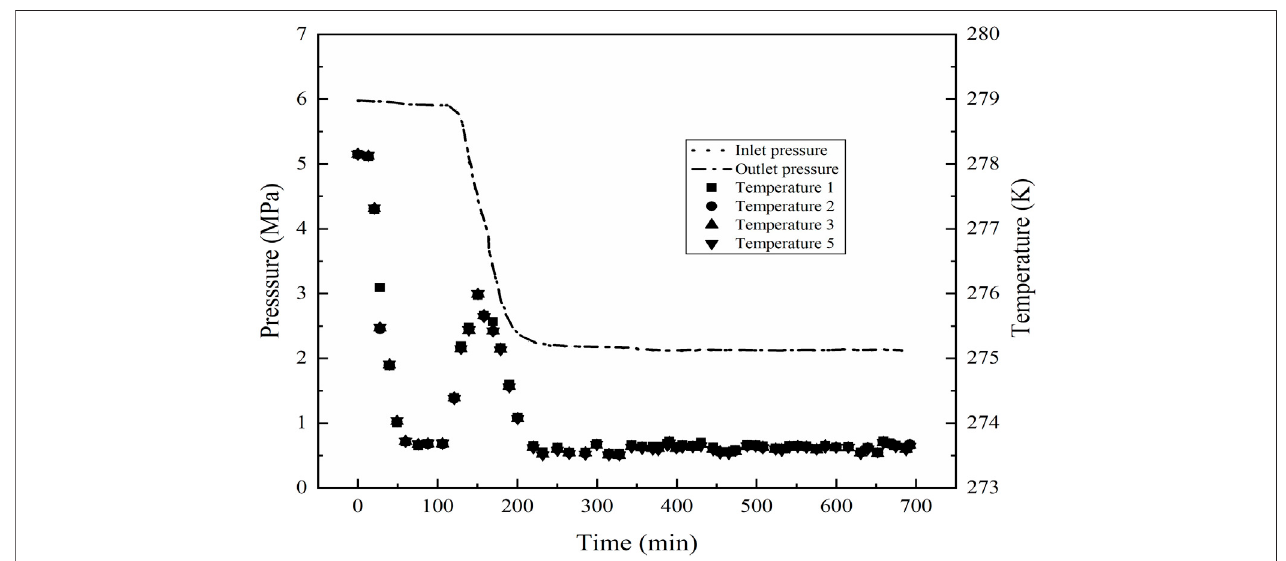
FIGURE 3 | The changes in temperature and pressure during GHs formation.